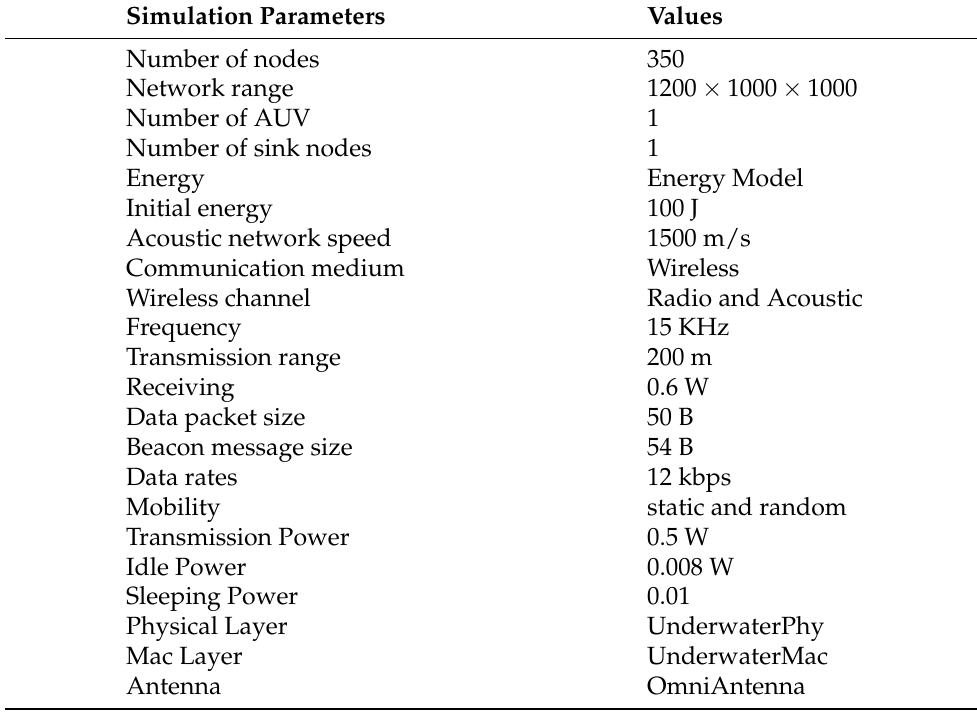
Table 1. Simulation settings and their